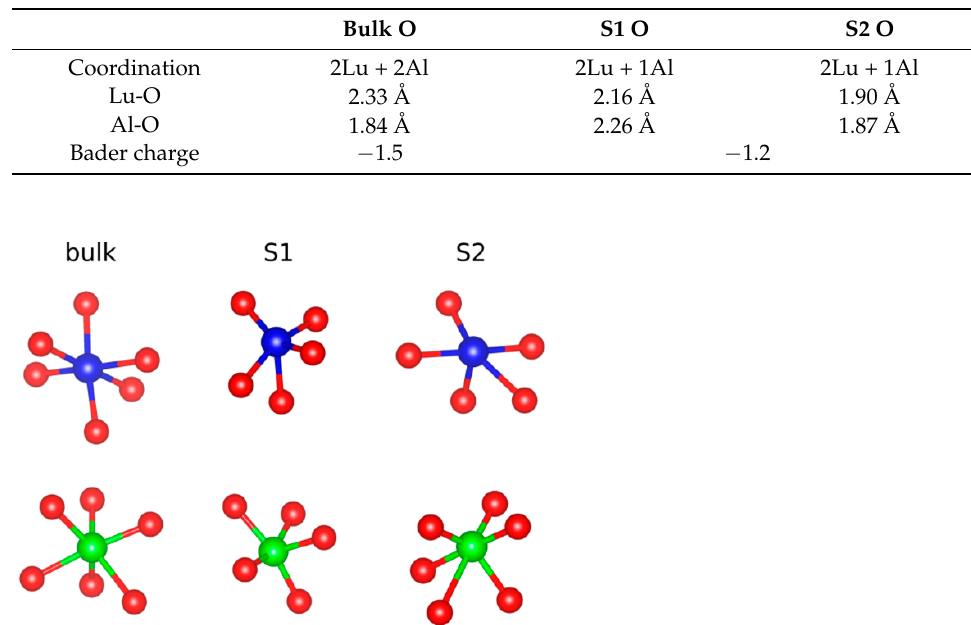
Figure 2. Local structure for the O vacant site in the bulk and on the surfaces. The Lu, Al, and O atoms are shown in blue, green, and red. Table 2. The calculated structure and Bader charge state of O atom in the bulk and surface.